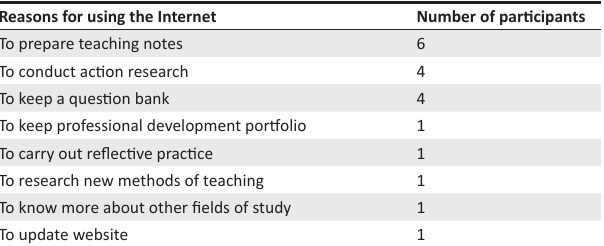
TABLE 1: Professional reasons for using Information and communication technology ( N =